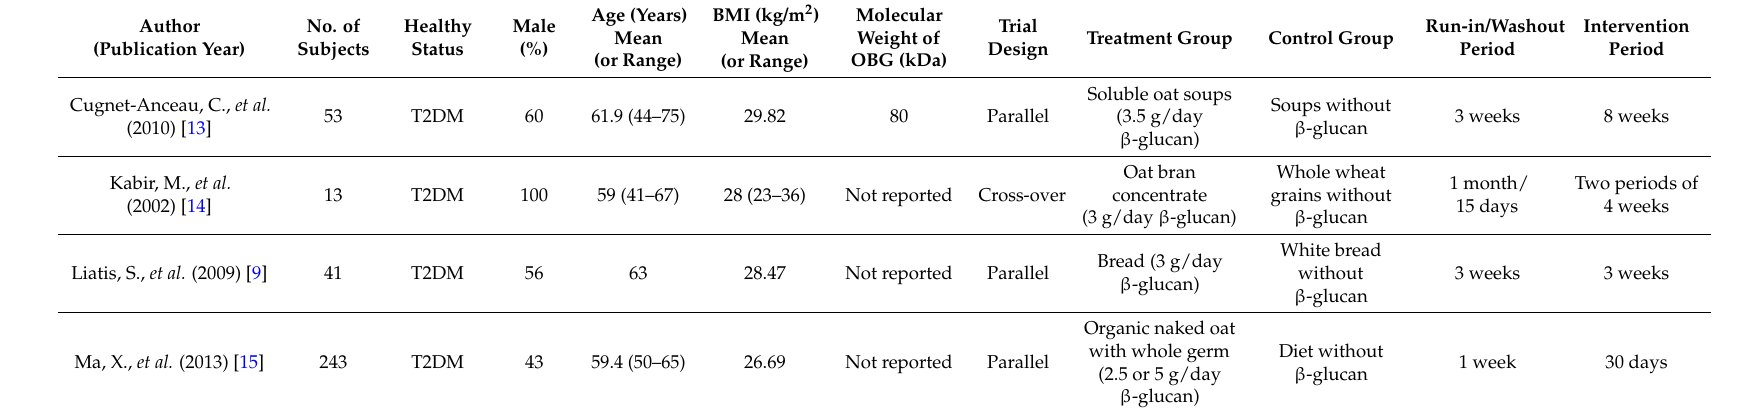
Table 1. Characteristics of the four included randomized controlled